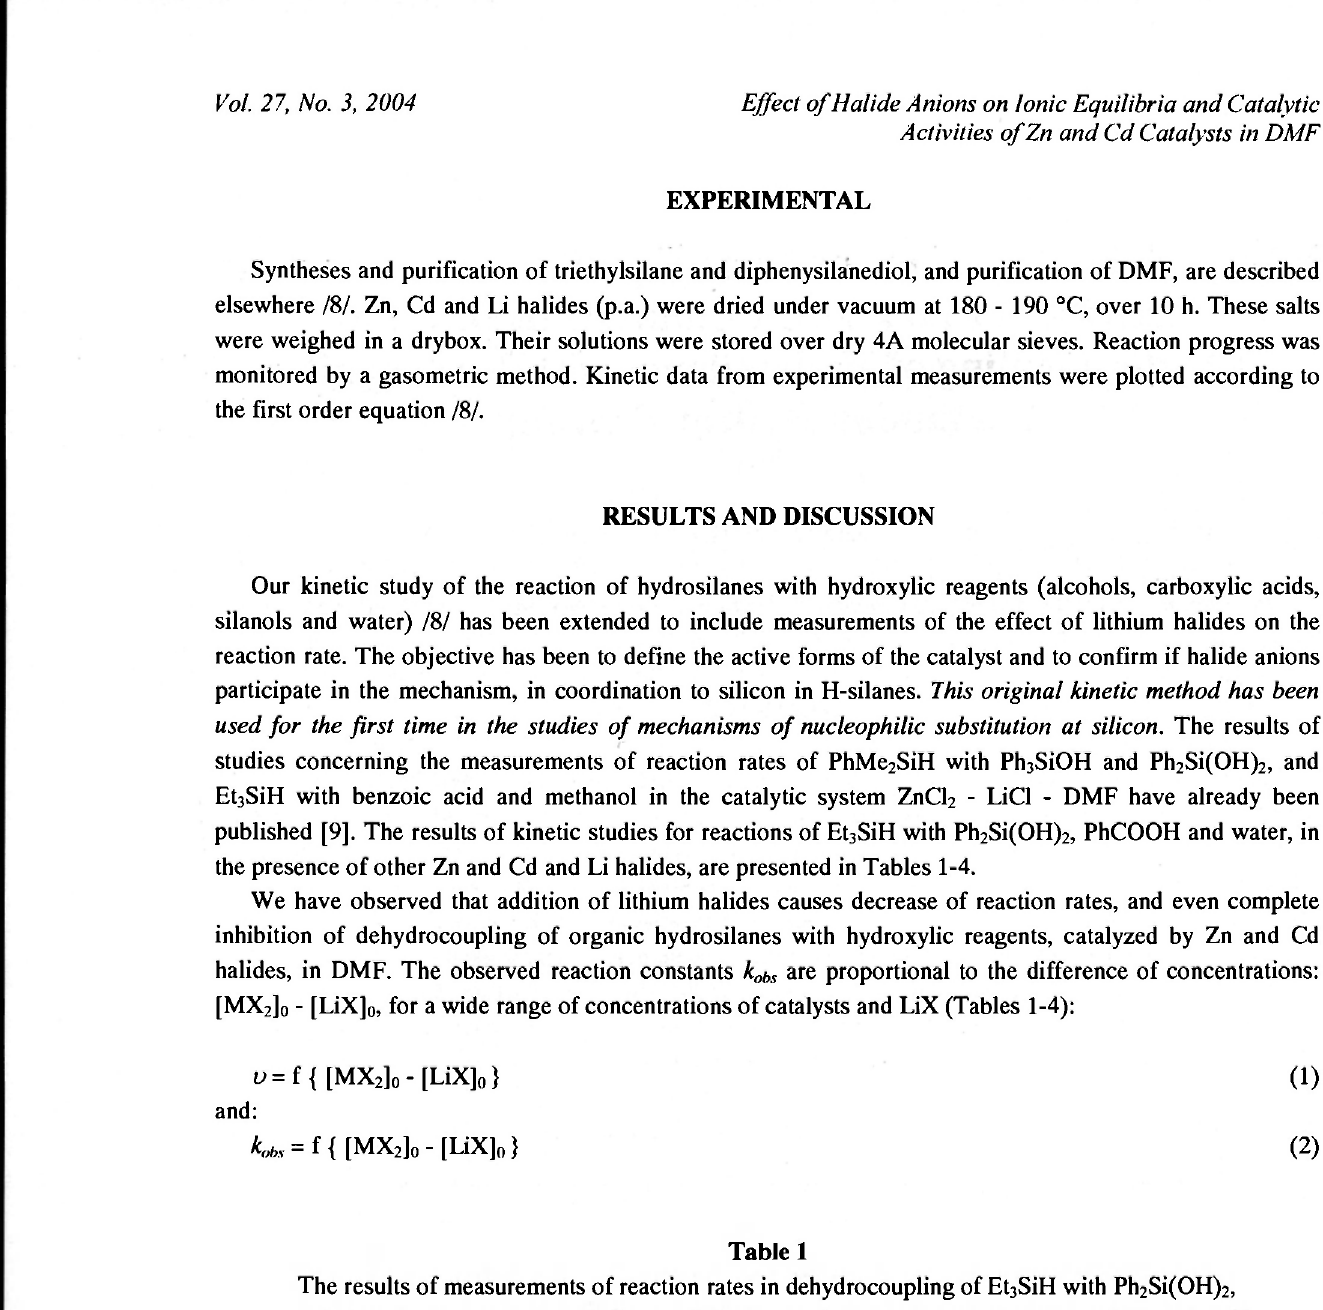
(expts. 7-11), in DMF at 25.0